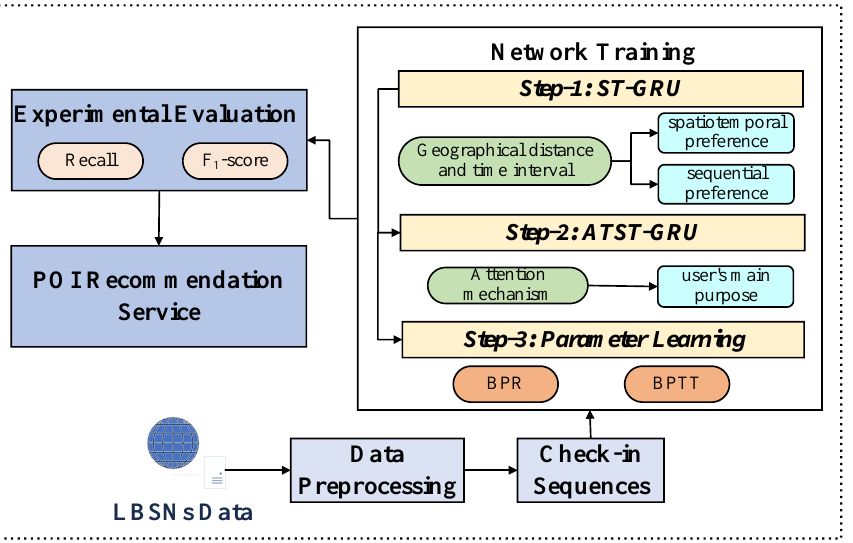
Figure 2. Architecture of the proposed method for point-of-interest (POI) recommendation.